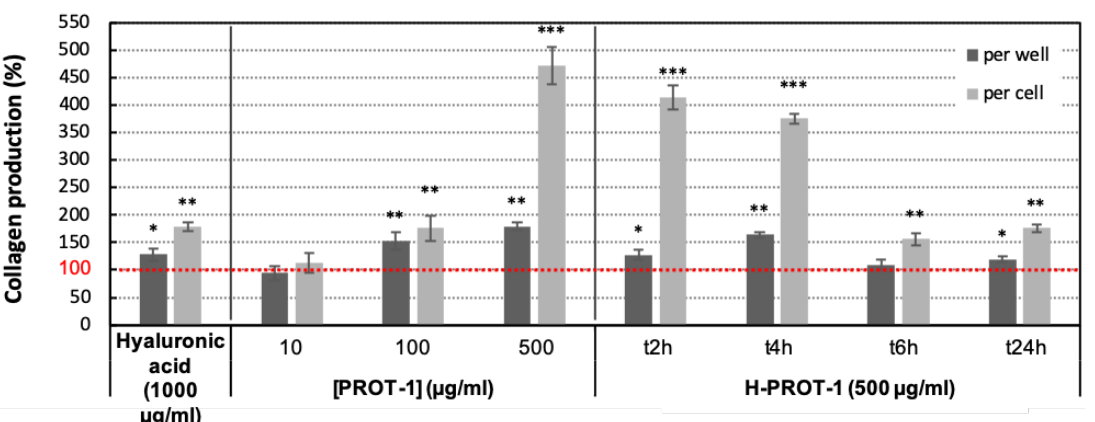
Figure 7. Collagen production per well and per cell by the human dermal fibroblast cell line 1059. Results are expressed as the mean relative percentage of production, compared to the negative control (100%). Significant differences between values obtained with samples and negative control ( n = 9) are indicated by * ( p < 0.05), ** ( p < 0.01) and *** ( p < 0.001).